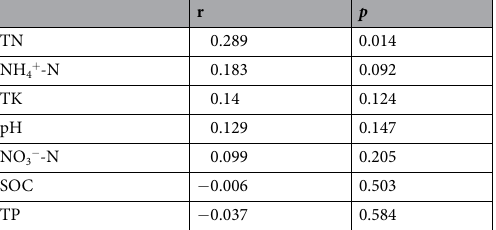
Table 2. The Spearman’s correlations (r) between the environmental variables and the fungal community structure (Bray-Curtis distance) determined by the Mantel test.